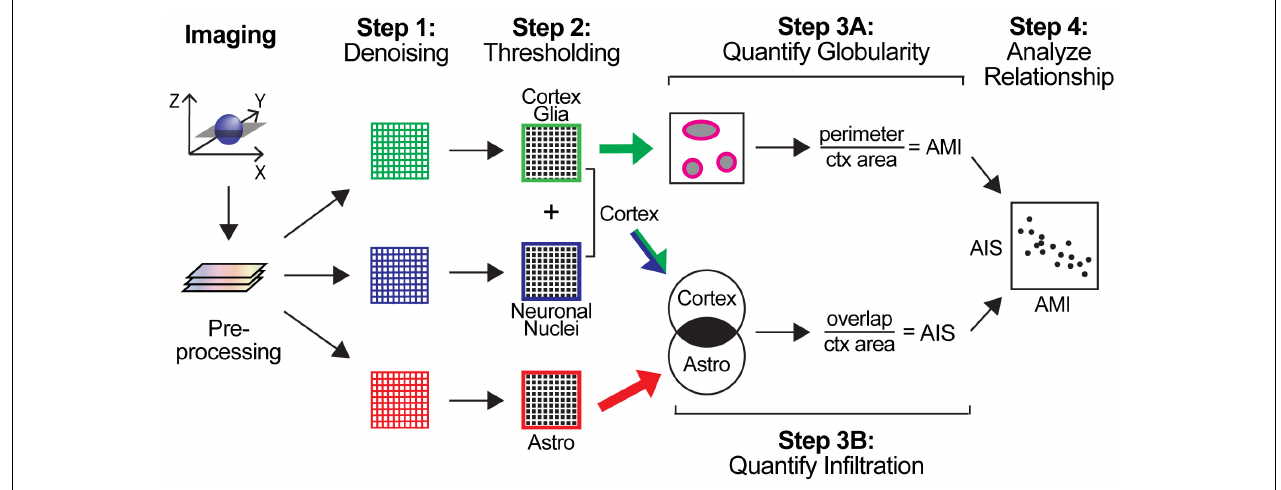
FIGURE 2 | Schematic of automated image analysis pipeline for 3-channel confocal Z-stacks. Preprocessing: Z-stacks were separated into 2D arrays representing a single plane for each cell type (corresponding to a single channel for each). Step 1: Individual channel images were denoised. Step 2: 2D arrays were thresholded to produce binary images. Step 3A: The perimeter of cells in the cortex glia (CG) channel was measured and normalized to total cortex area producing an automated morphology index (AMI) score. Step 3B: CG and neuronal nuclei channels were combined to define the cortex area (ctx). The overlap between the ctx and astrocyte (astro) channels was calculated and normalized to the total cortex area to produce an automated infiltration score (AIS). Step 4: The relationship between the AMI and AIS was